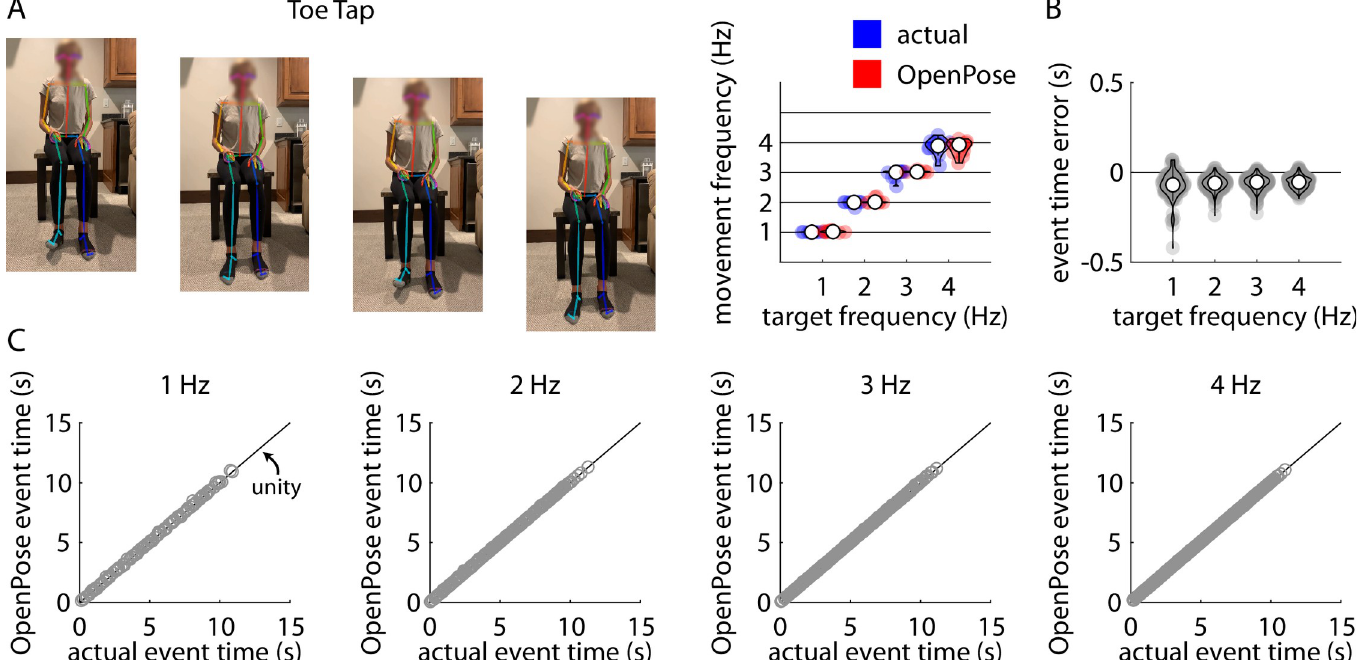
Fig 5. A) Representative example of stillframes from an OpenPose output video of a participant performing the toe tapping task (left) and violin plots showing comparisons of individual participant mean toe tapping frequencies measured manually (“actual”, blue) and using our pose estimation workflow (“OpenPose”, red) across all four target frequencies (right). B) Violin plots showing event time errors (i.e., differences between video timestamps of toe taps as measured manually and using pose estimation) for each individual toe tap across all participants. C) Scatter plots showing relationships between the video timestamps of all individual toe taps across all participants as measured manually (x-axis) or using our pose estimation workflow (y-axis) across all four target